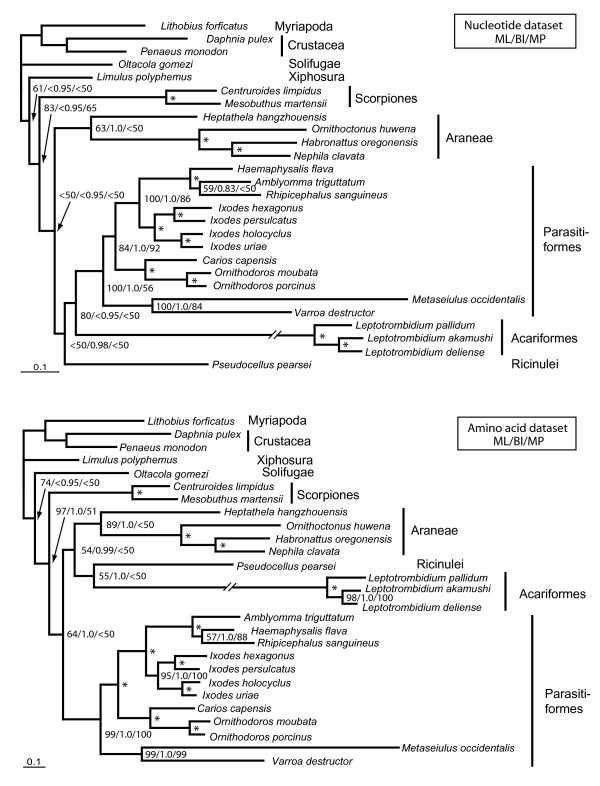
Phylogenetic trees of chelicerate relationships, inferred from nucleotide (upper) and amino acid (lower) datasets. All protein coding gene sequences were aligned and concatenated; ambiguously aligned regions were omitted by Gblocks. Trees were rooted with outgroup taxa (Lithobius, Daphnia, Penaeus). Topologies and branch lengths were taken from the best scoring trees of the maximum likelihood (ML) analyses. Numbers behind the branching points are percentages from ML bootstrapping (left), Bayesian posterior probabilities (BPP, middle) and maximum parsimony bootstrap percentages (MP, right). Stars indicate that values are 100 (ML), 1.0 (BI) and 100 (MP). See Table 2 for accession numbers.